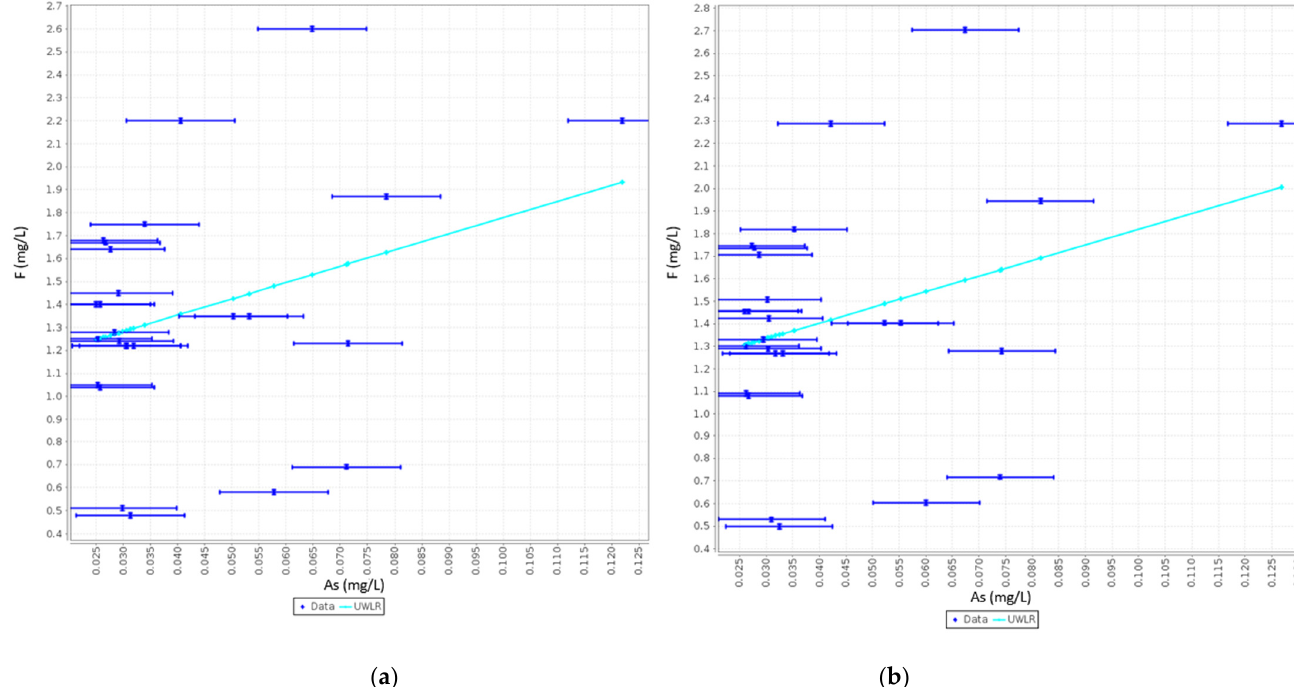
Figure 8. As and F correlation for the highest values of As: ( a ) 2015; ( b ) 2020. The model found is shown in Equation (5) for 2015 and Equation (6) for